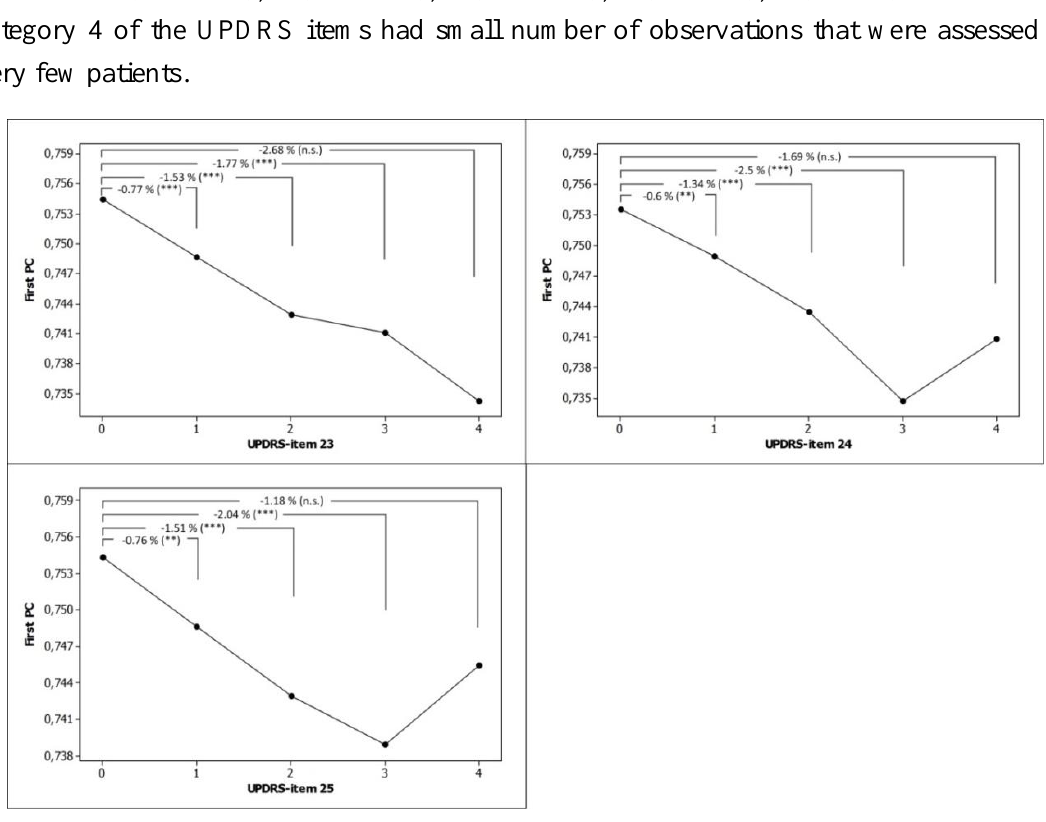
Figure 4. Mean scores of First PC for each category of items #23 (Finger Tapping), #24 (Hand Movements) and #25 (Rapid Alternating Movements of Hands) of the UPDRS scale, corrected for individual subject variation using linear-mixed effects models. Y-axis: a high score means good function. UPDRS items: 0 (Normal), 1 (Mild slowing and/or reduction in amplitude), 2 (Moderately impaired), 3 (Severely impaired) and 4 (Can barely perform the task). P-values and % changes are shown with respect to category 0.